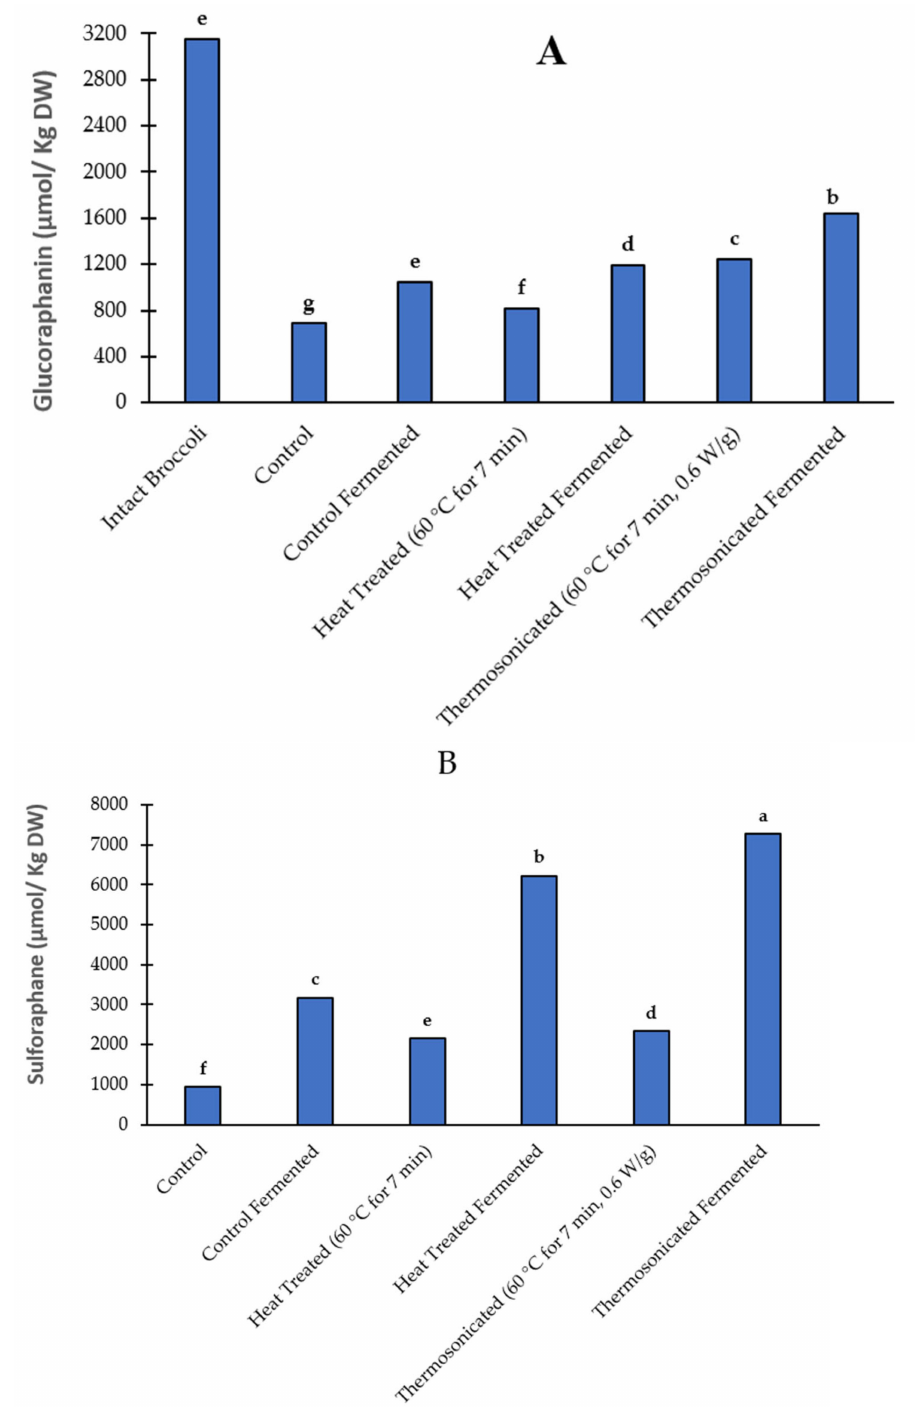
Figure 1. Effects of thermal or thermosonication treatments of broccoli florets on glucoraphanin ( A ) and sulforaphane ( B ) content of broccoli purees before and after lactic acid fermentation. ‘Control’ denotes non-pre-treated broccoli puree. Different lowercase letters (a to f) over the bars denote significant differences ( p <